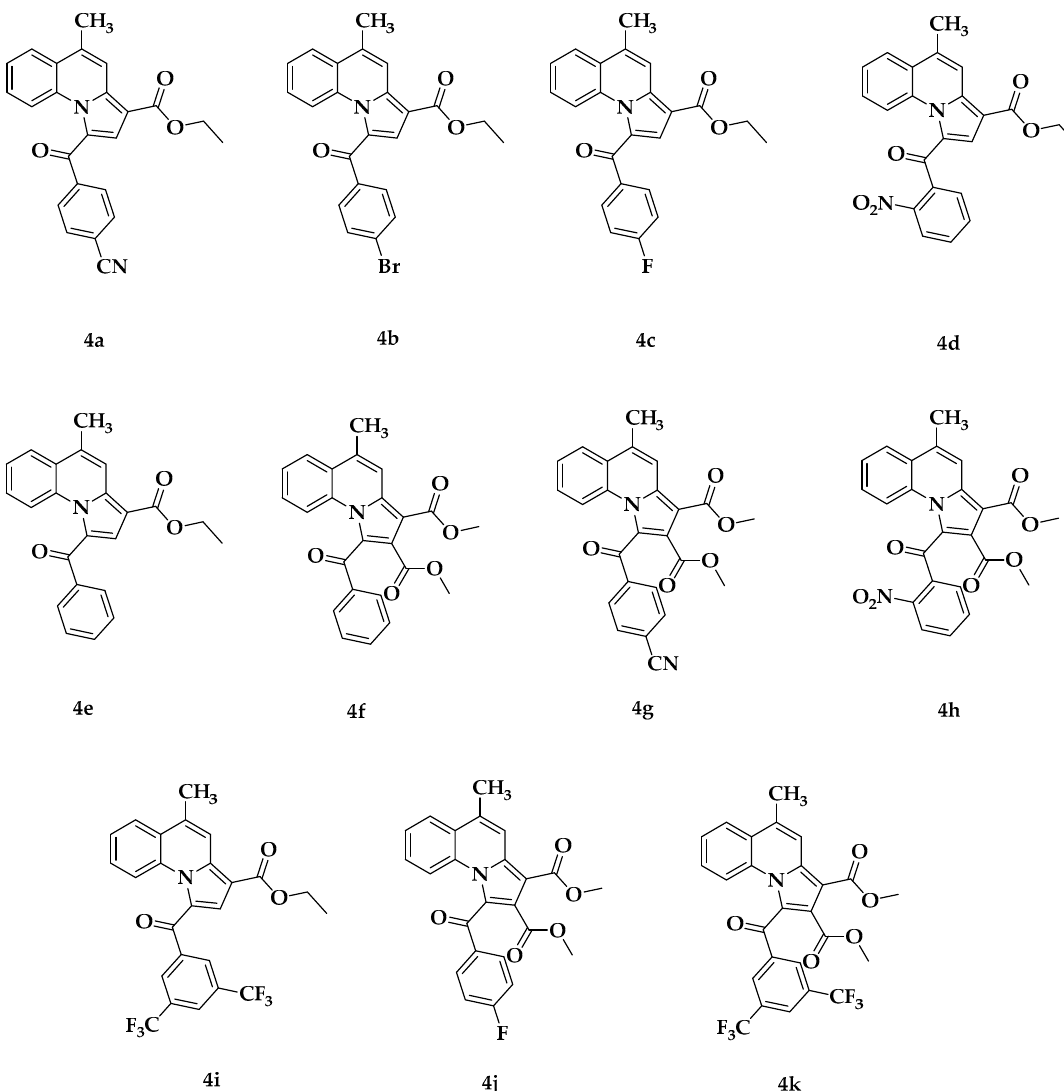
Figure 2. Chemical structure of ethyl 1-(substituted benzoyl)-5-methylpyrrolo[1,2- a ]quinoline-3- Figure2. Chemicalstructureofethyl1-(substitutedbenzoyl)-5-methylpyrrolo[1,2- a